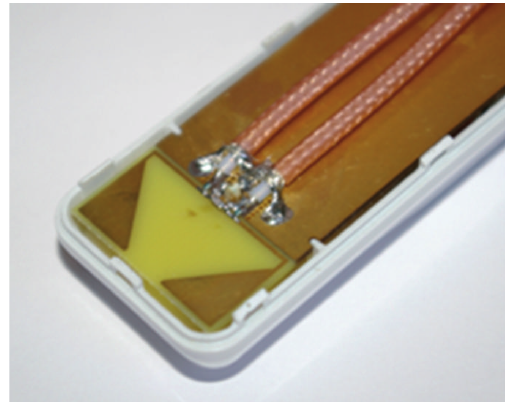
Figure 10: Photo of the fabricated MIMO antenna system #2 assembled with the cables.